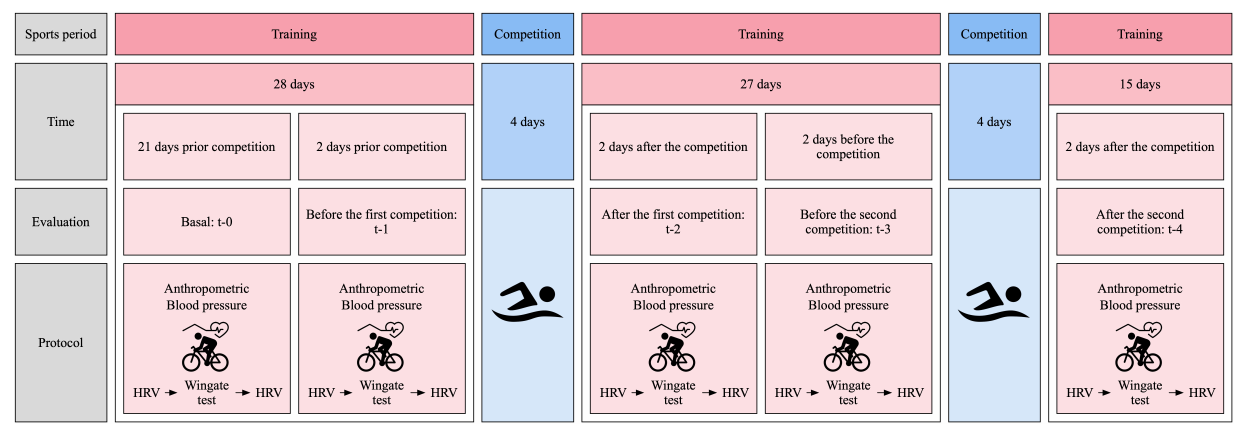
FIGURE 1 | Study design and evaluations were carried out. Heart rate variability (HRV) was evaluated before and after the anaerobic physical fatigue test (Wingate test).